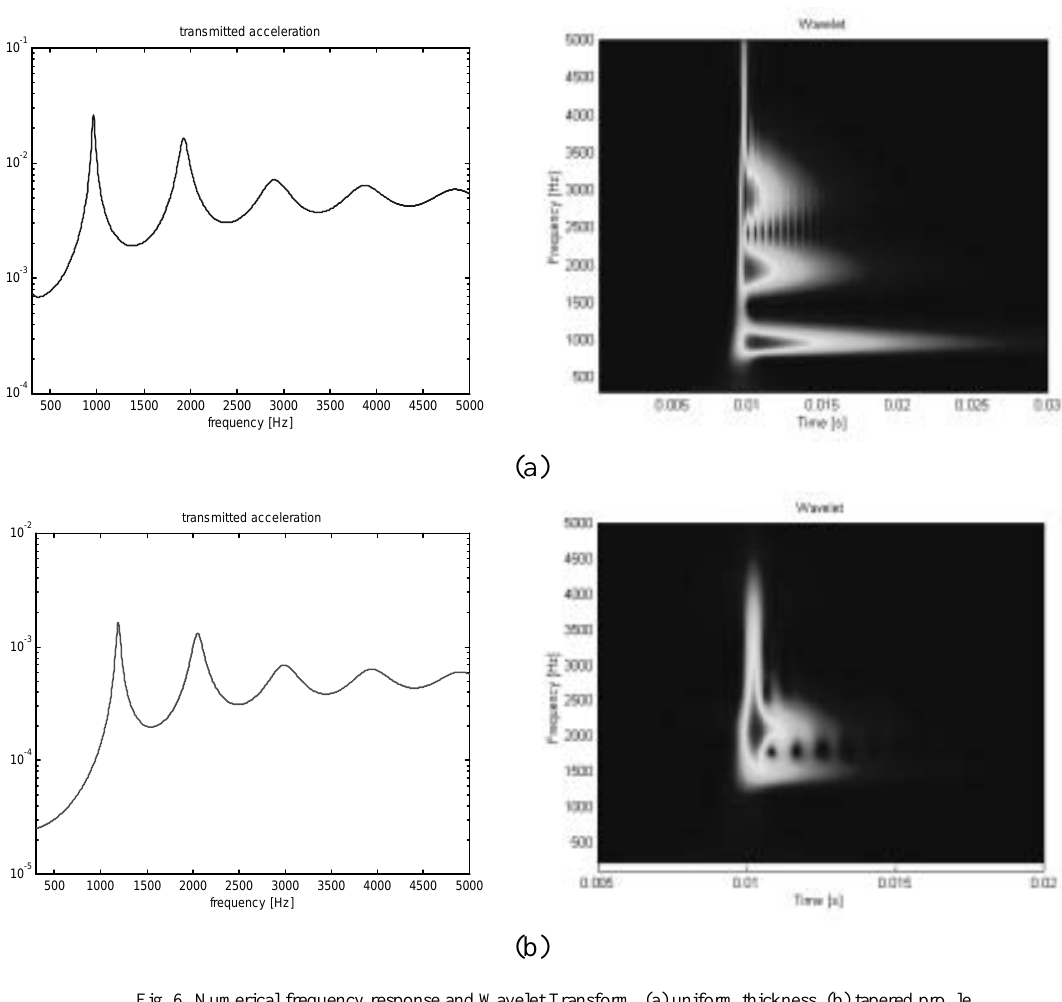
Fig. 6. Numerical frequency response and Wavelet Transform. (a) uniform thickness, (b) tapered